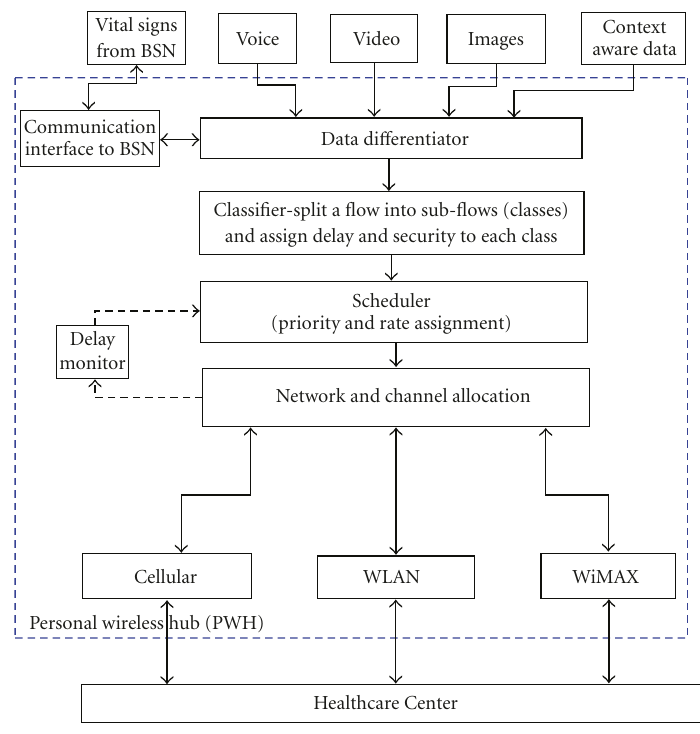
Figure 2: Modules that constitute a PWH. Operation of the